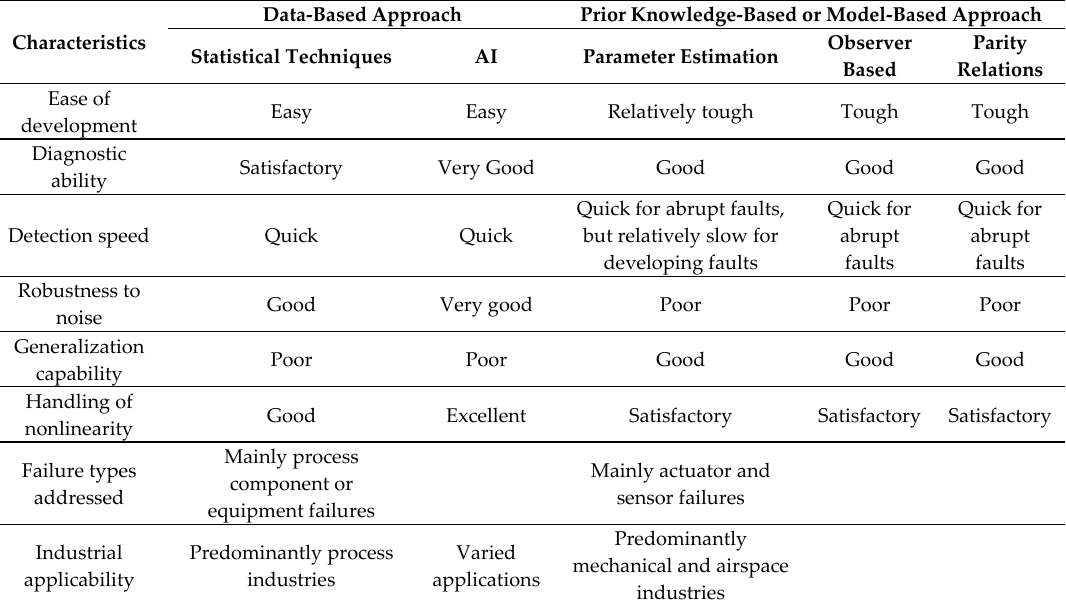
Table 8. Comparison between strategies of the monitoring process and fault